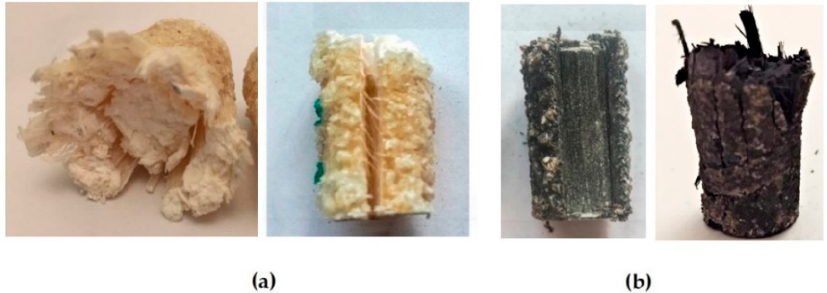
Figure 4. Experimental failure modes for the selected ( a ) GFRP and ( b ) BFRP bar specimens.